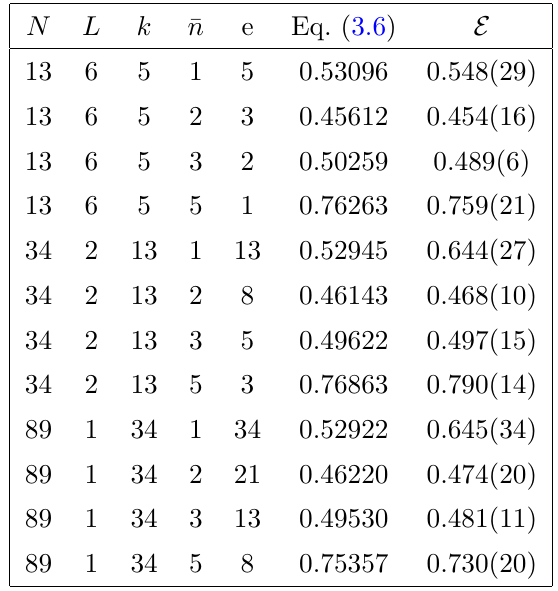
or n E with E ~n given by ( n; 0) (1 ; 0)